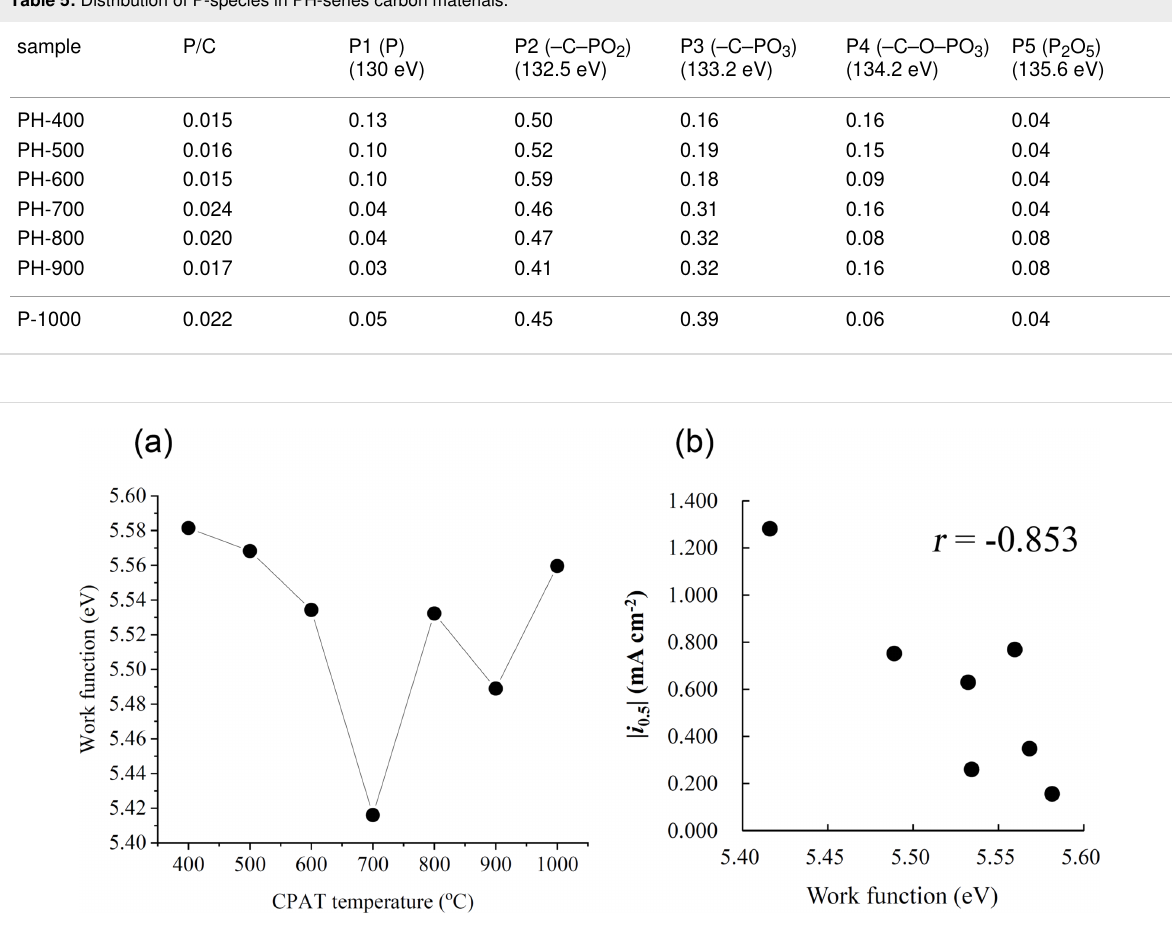
Table 5: Distribution of P-species in PH-series carbon materials.